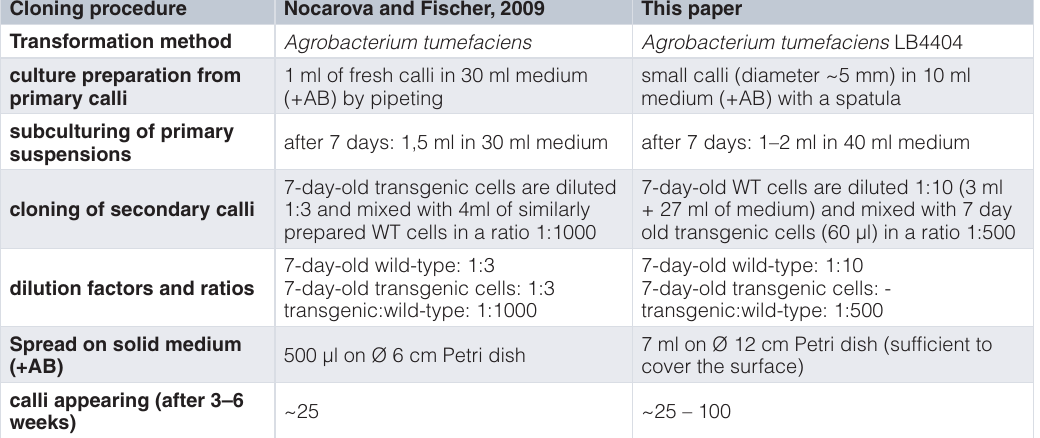
Table 2. Comparison of the cloning procedures of transgenic tobacco BY-2